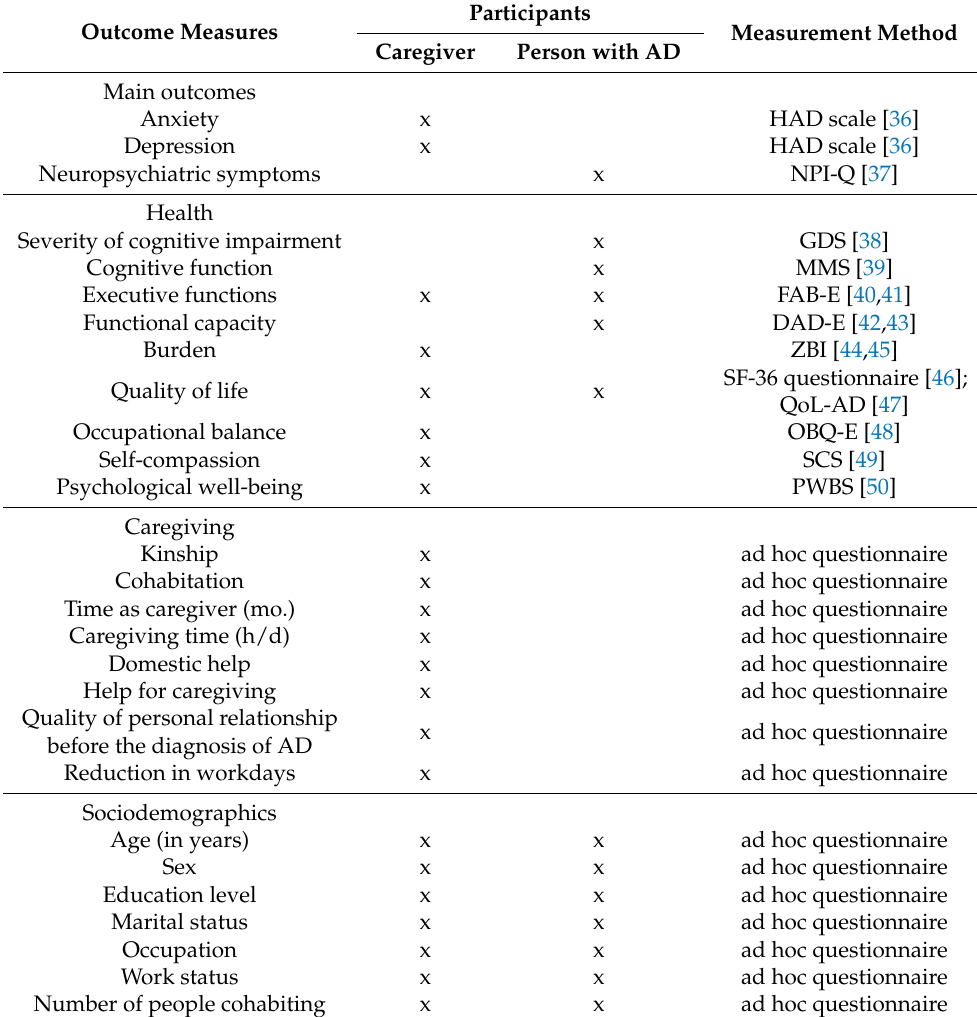
Table 2. Summary of the data collection for the ATENEA